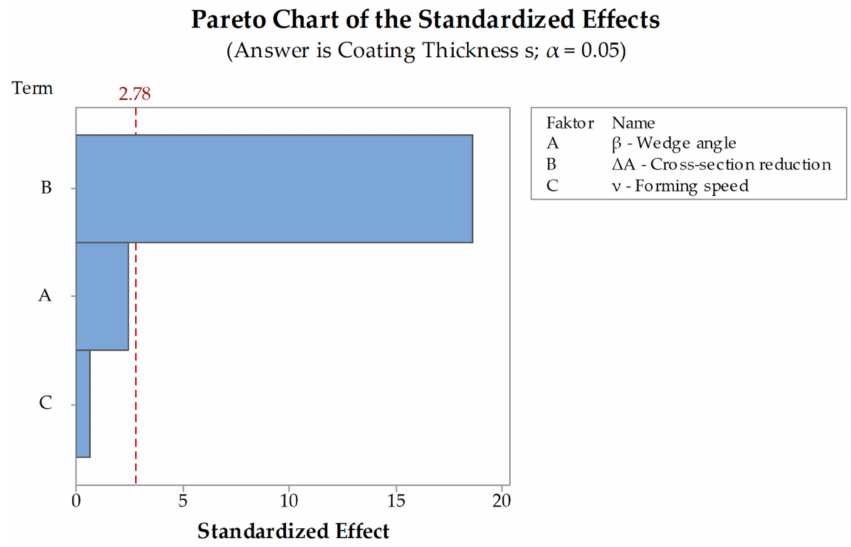
Figure 7. Pareto chart of the standardized e ff ects for the coating thickness s in the simulations.